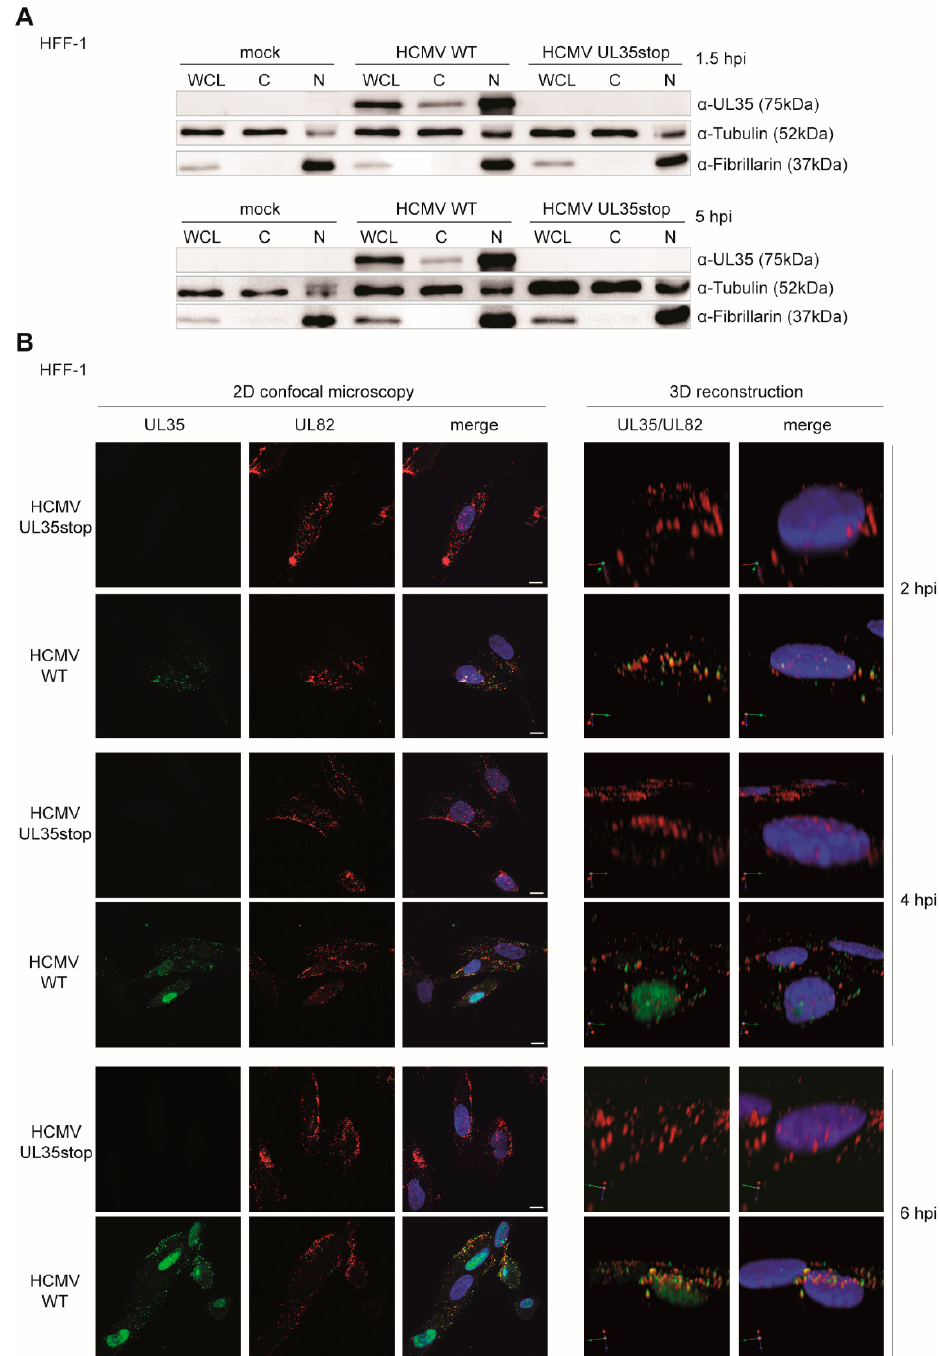
Figure 3. Dynamics of tegument-derived UL35 at early stages of HCMV infection. ( A ) HFF-1 were either mock infected or infected with HCMV WT or UL35stop for 1.5 h (upper panel) or 5 h (lower panel) at an MOI of 0.5. Whole cell lysates (WCL) were harvested and separated into cytoplasmic (C) and nuclear (N) fractions. Expression of UL35 was analyzed by immunoblotting with an anti-UL35 antibody. Tubulin and fibrillarin were used as controls for cytoplasmic and nuclear fractions, respectively. ( B ) HFF-1 were seeded on ibidi µ-slides and infected with HCMV WT or UL35stop at an MOI of 5. Cells were fixed at the indicated time points and immunolabeled with anti-UL35 (green) and anti-UL82 (red) antibodies. Nuclei (blue) were stained with DAPI. Images were acquired by confocal microscopy. Z-stacks were used for 3D reconstruction. Scale bars represent 10µm. hpi: hours post infection 3.4. Tegument UL35 Negatively Modulates IFN β Induction in HCMV-Infected Fibroblasts